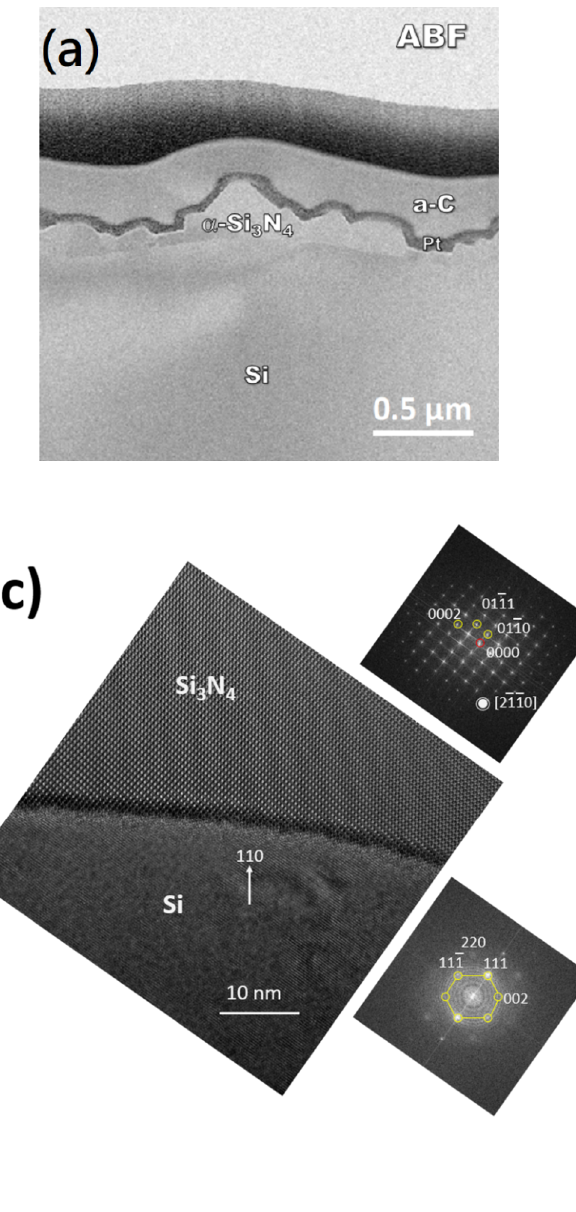
Figure 3. ( a , b ) Low magnification cross-sectional STEM–ABF and ADF images of α-Si 3 N 4 on Si, respectively; ( c ) HRTEM image of the Si 3 N 4 /Si interface from the central region in ( a ) with the corresponding FFT patterns of α-Si 3 N 4 and Si; ( d ) Atomic resolution STEM-ADF image of the α-Si 3 N 4 /Si interface with the corresponding FFT pattern of α-Si 3 N 4 in zone axis [ 112(cid:3364)0 ].